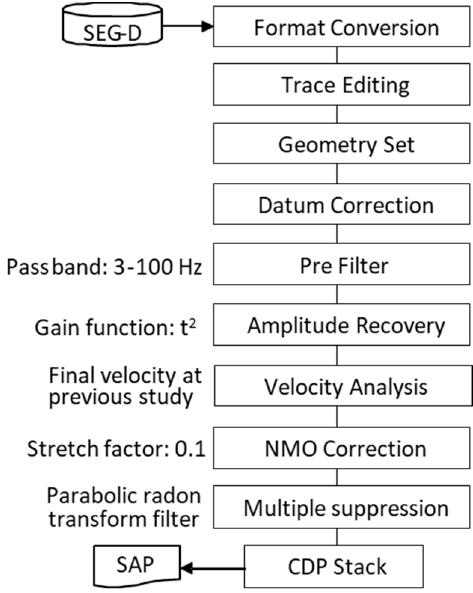
Figure 3. Flow chart of the preprocessing of seismic reflection data for the present SAP study (modified after the previous study [3]). To avoid the frequency distortion of reflections, deconvolution was excluded in the preprocessing sequence for SAP analysis. NMO correction was applied with a very small stretching factor of 0.1, which did not allow NMO stretch to exceed 10%.